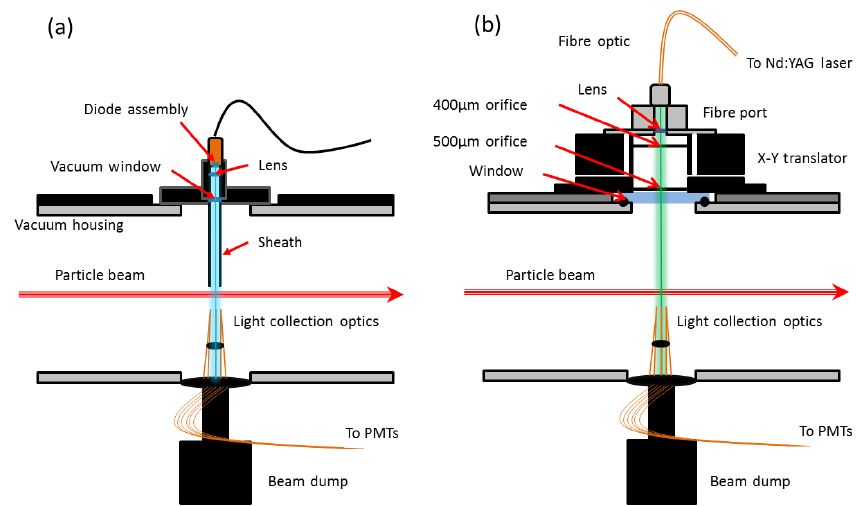
Figure 2. Schematic diagrams of the LAAP-TOF detection stages. (a) Detection system A featuring a 405nm diode-based system with a focussed beam ( D 4 σ of 51 . 2µm) and a sheath type spatial filter. (b) Detection system B featuring a custom-built 532nm Nd:YAG DPSS fibre-coupled system producing a collimated beam with a 1 /e 2 waist diameter of 330µm, and spatial filtering outside the vacuum housing.